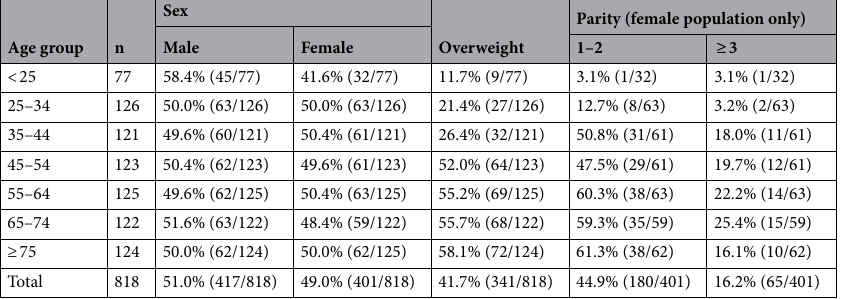
Table 1. Patient characteristics by age group. For parity, percentages are given for women of the respective age group only, not for entire age group.